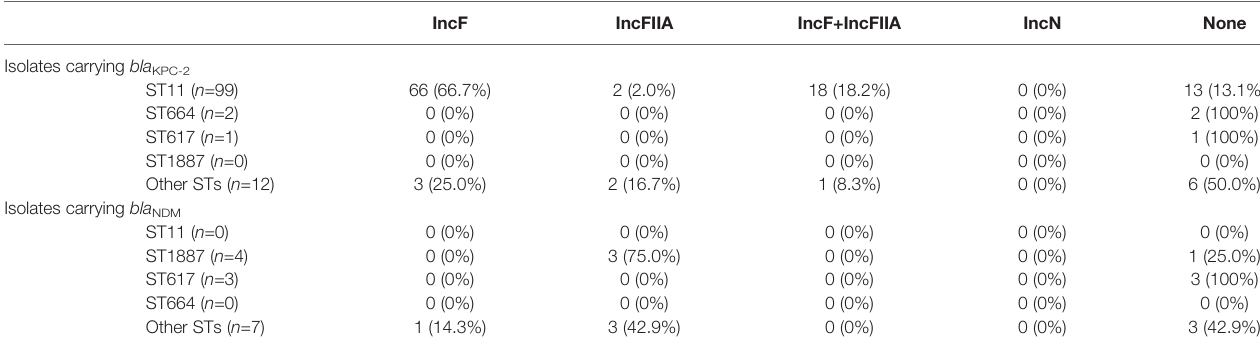
TABLE 2 | Incompatible plasmids in different ST isolates carrying bla KPC-2 or bla NDM . IncF IncFIIA IncF+IncFIIA IncN None Isolates carrying bla KPC-2 ST11 ( n =99)